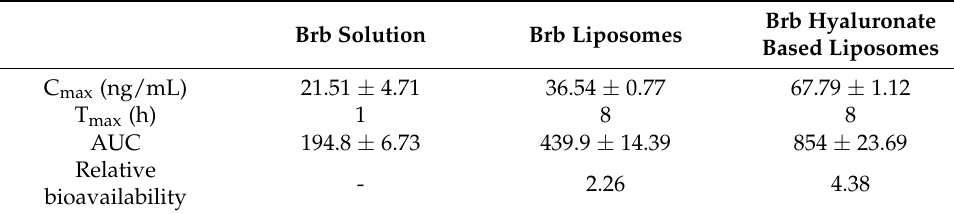
Figure 4. Plasma concentration profiles of berberine in rats after oral administrations of 50 mg/kg of berberine in various formulations. Each point represents mean ± standard deviation (N = 6). Table 3. The calculated pharmacokinetic parameters of rats in different groups after administration of a single oral dose of berberine of 50 mg/kg body